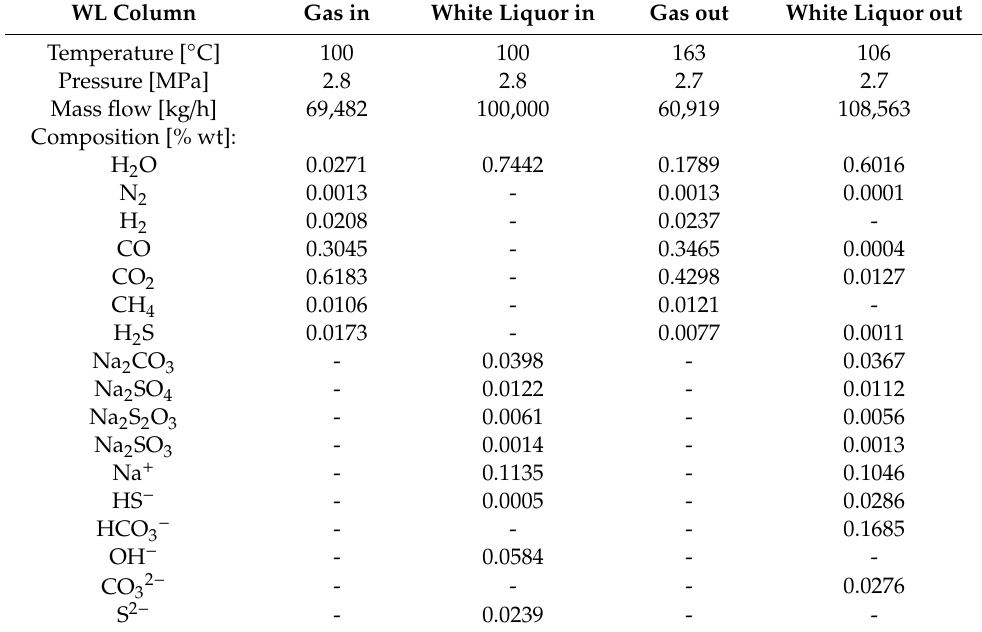
Table A2. Detailed white liquor column operation simulation results.